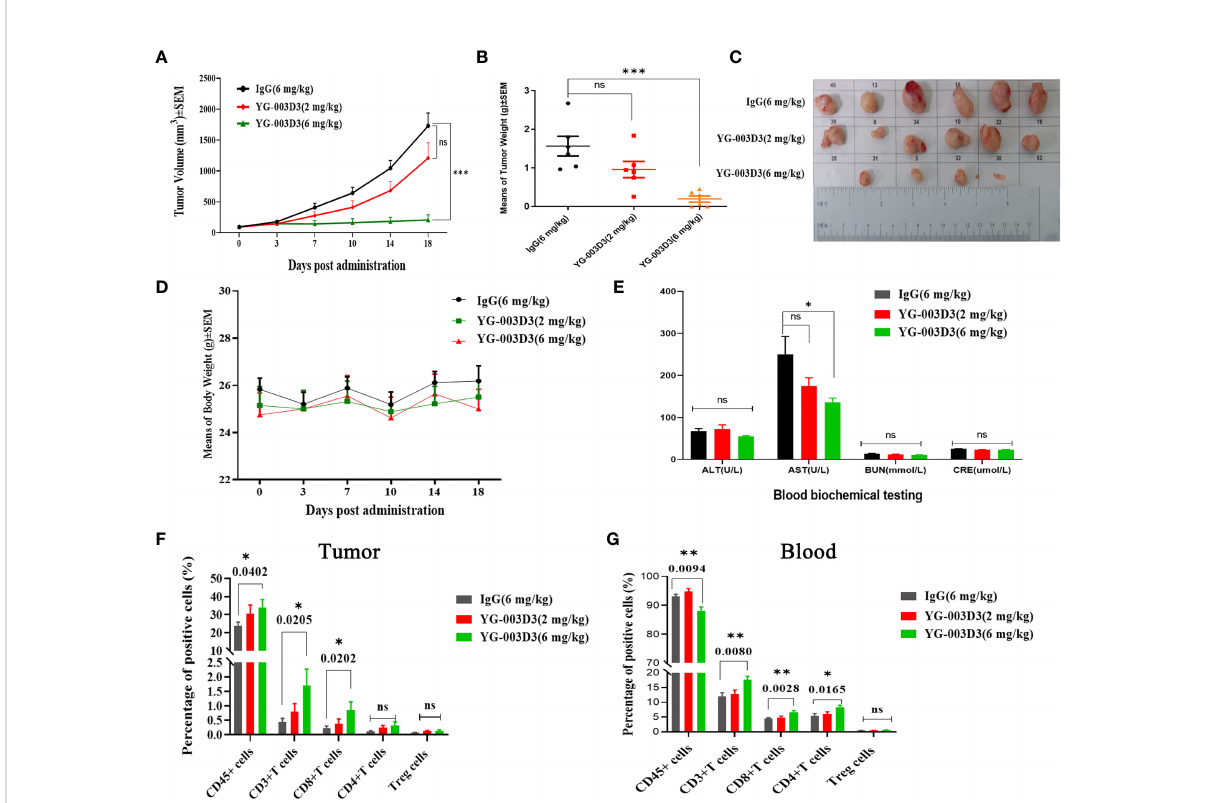
FIGURE 5 Anti-tumor effect of YG-003D3 in the humanized mouse model. (A) Tumor growth trend chart in human PD-1/LAG-3 double knock-in mice bearing MC38(hPD-L1) were treated with antibodies. (B) At the end of the experiment, animals were euthanized, and tumor blocks were stripped and weighed. The tumor weight of the IgG control group was 1.5633 ± 0.2560g, and the tumor weight of the median-dose YG-003 D3 group was 0.1954 ± 0.0815g. The tumor weight inhibition rate (IR) was as high as 87.50%, which was signi fi cantly different from the tumor volume of the control group (P < 0.001). (C) Inspection of tumor tissues excised from each group at the end of the study. (D) Mouse body weight changes during antibody drug therapy. (E) Blood biochemistry data after the experiment. (F) Detection of the proportion of immune cells of various class in tumor tissues. (G) Detection of the proportion of immune cells of various class in the peripheral blood. The results demonstrate that YG-003D3 can induce an increase in the proportion of T cells exerting a tumor-killing effect in tumors and peripheral blood, and exert an excellent antitumor effect. Dates were considered statistically signi fi cant when p values lower than 0.05 (*p <0.05, **p < 0.01 and